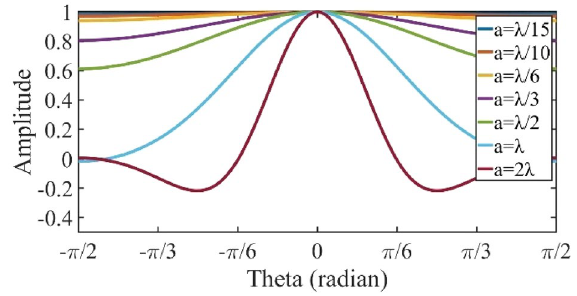
Figure 3. The magnitude of a one-dimensional sinc function for different values of a